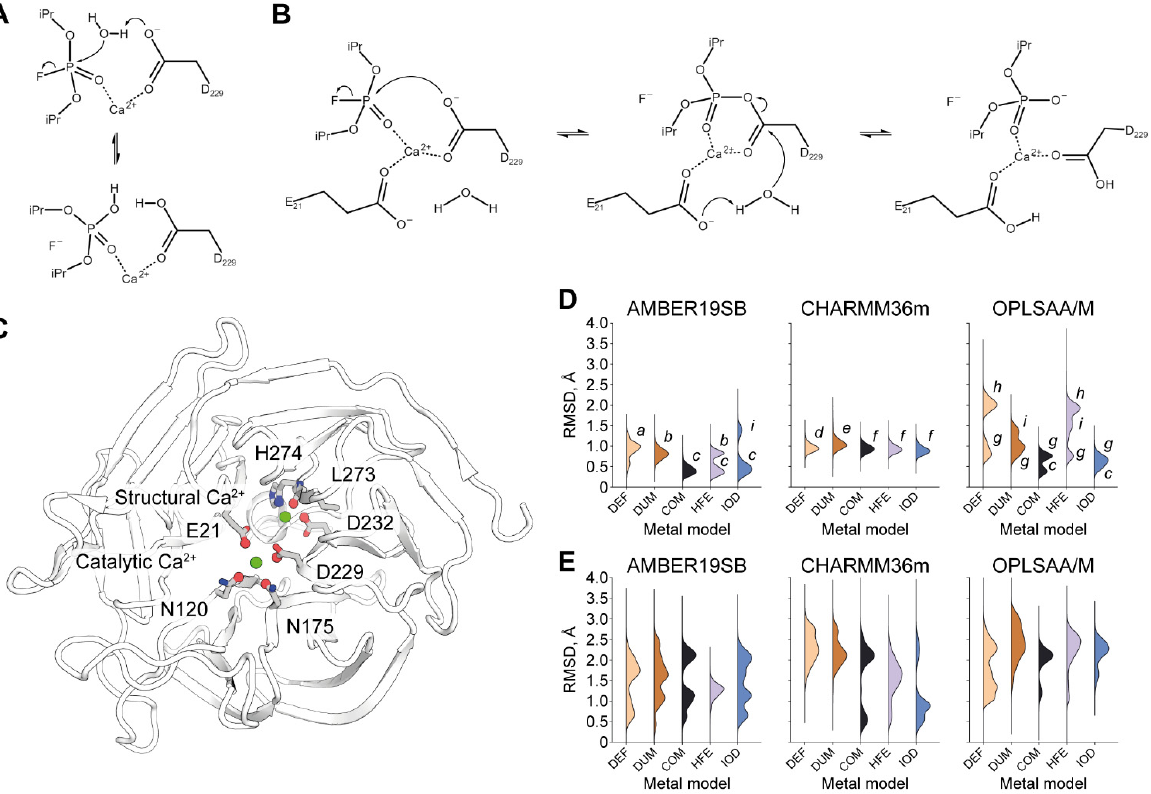
Figure 1. Overview of DFPase reaction, calcium-binding sites and modeling of their dynamic behavior. ( A ). A scheme of the proposed general-base reaction mechanism. ( B ) A scheme of the proposed nucleophilic reaction mechanism. ( C ) DFPase structure. Coordinating residues are highlighted. Atoms involved in RMSD calculation are shown as spheres. ( D ). Stability of catalytic Ca 2+ site. Individual states of interest are marked as lowercase letters to be referenced later on in text and figures. ( E ). Stability of structural Ca 2+ site. Each violin plot represents RMSD over the last 10 ns of 5 replicas for each parameter combination. Explanation of system naming can be found in the Materials and Methods section.